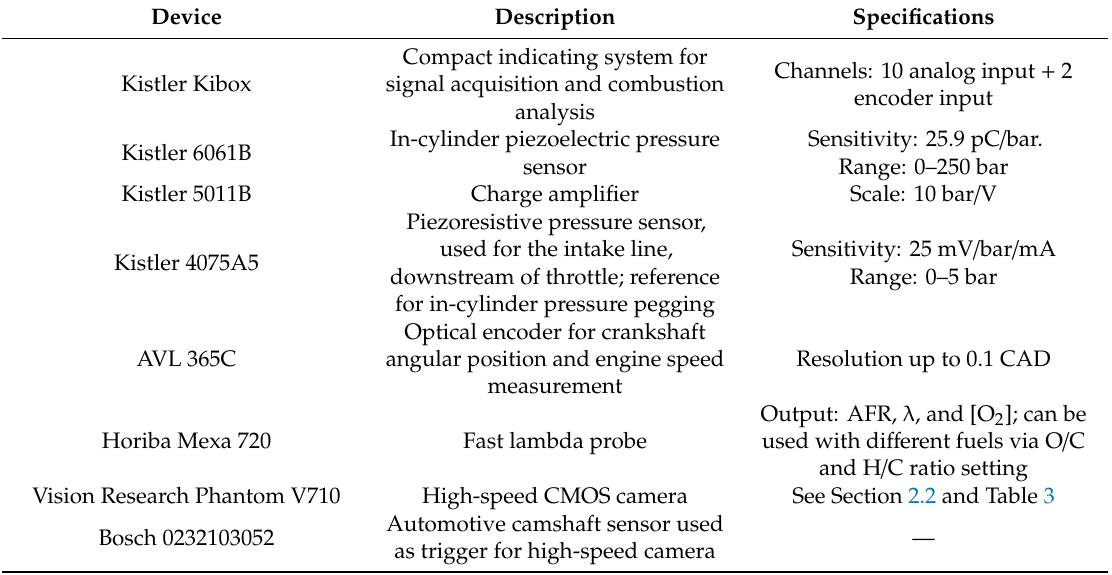
Figure 3. Schematic of measurement apparatus. Table 2. Measurement apparatus details. AFR—air–fuel